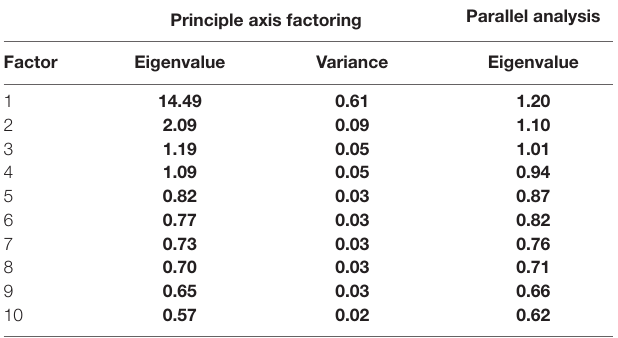
TaBle 2 | Principle axis factoring and parallel analysis values.